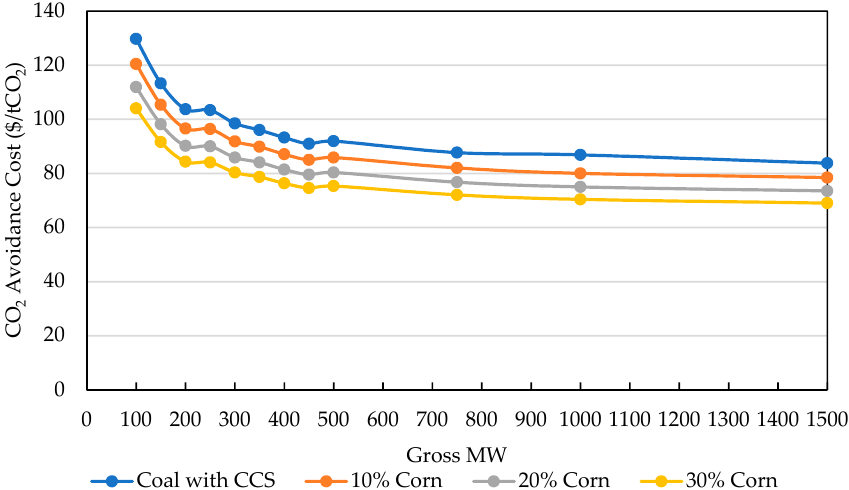
Figure 8. Predicted CAC values for corn-stover co-fired PCC power plants with CCS. A PCC power plant without carbon capture and storage is used as the reference case for CAC calculations.